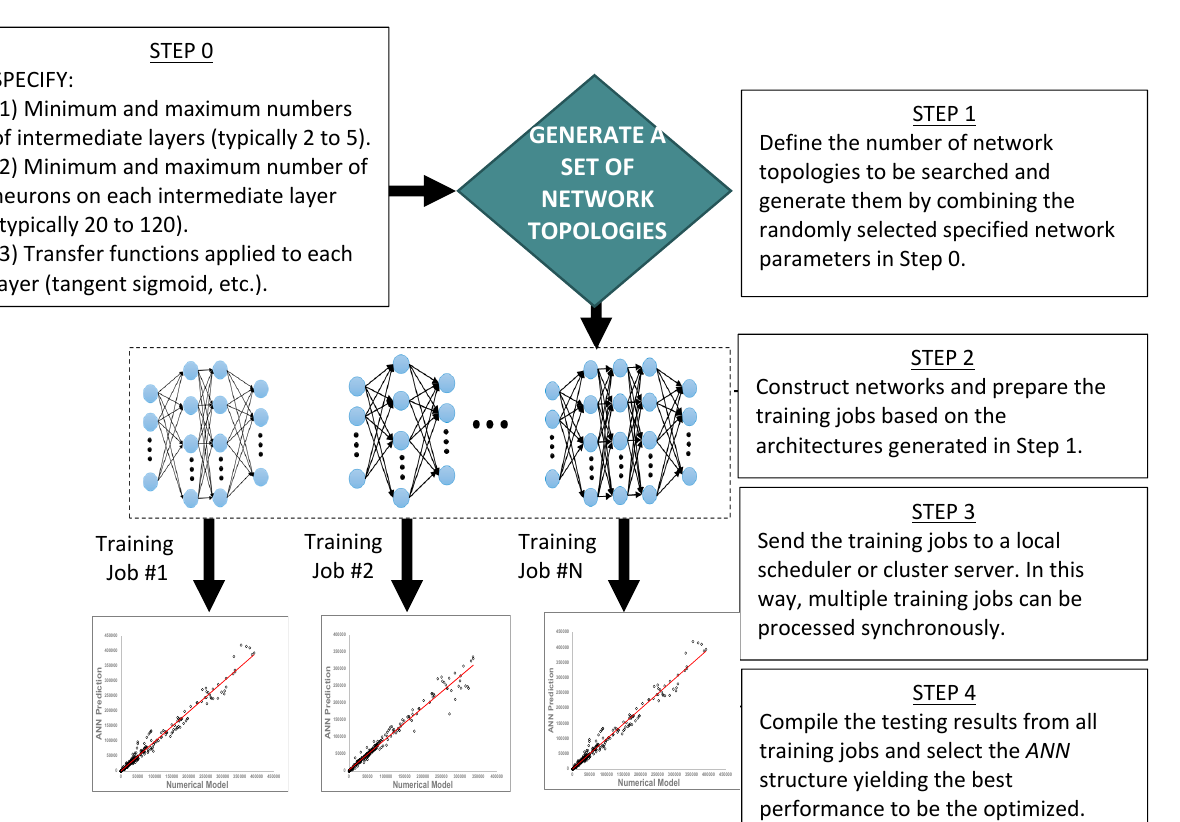
Figure 7. Suggested protocol for finding an optimized ANN architecture.